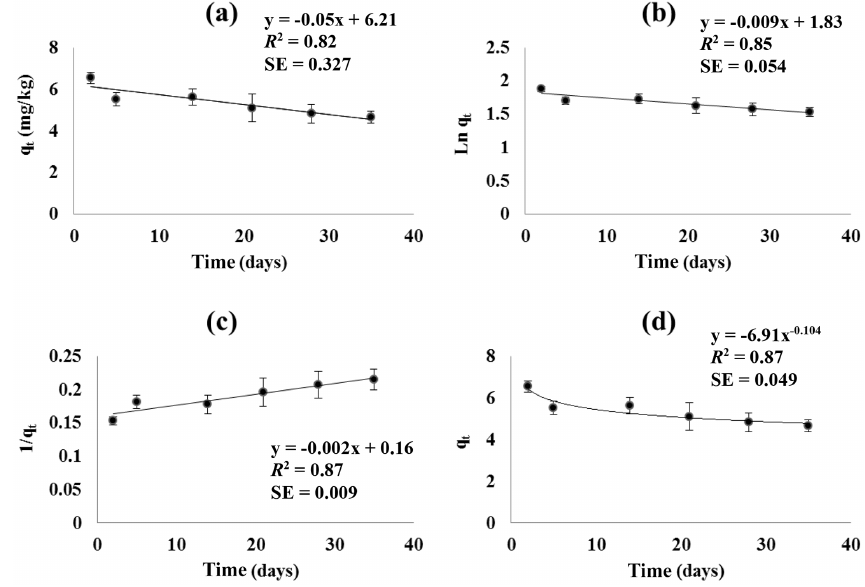
Figure 4. Amount of diethylene triamine pentaacetic acid (DTPA)-extractable copper over the short term (35 days) in the chelated system fitted to (a) zero-order, (b) first-order, (c) second-order, and (d) power function models ( q t denotes the amount remaining at time t (mgkg − 1 ); error bars are for standard errors computed from six data